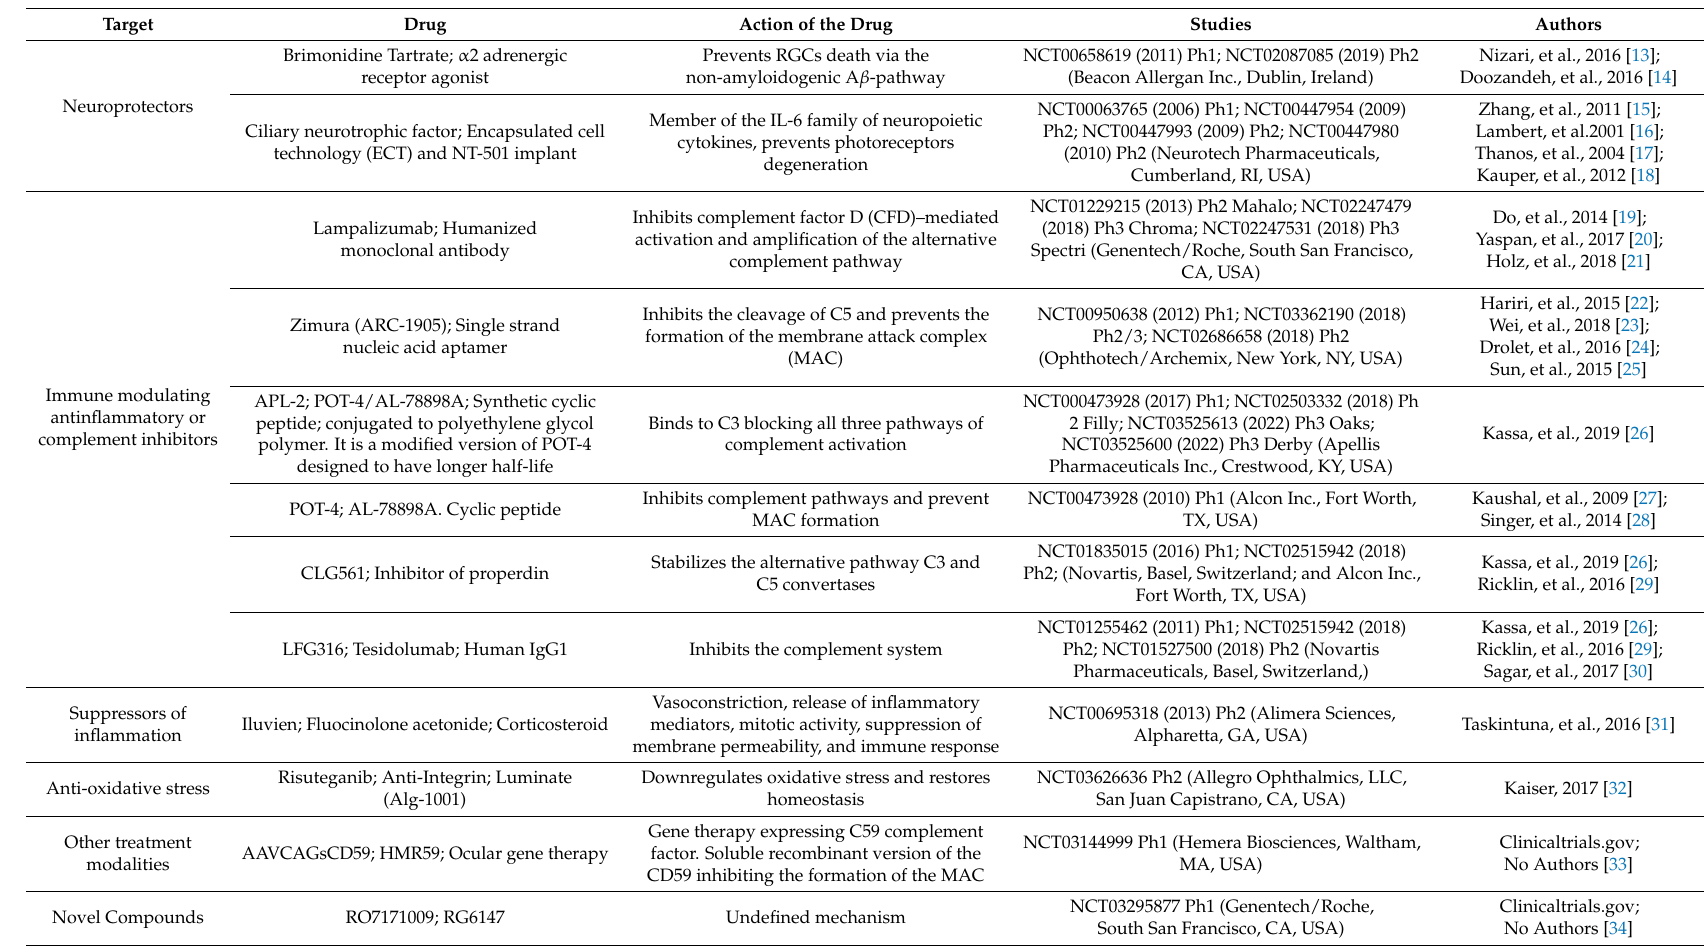
Table 1. Summary of the clinical trials for the intravitreal injections (IVIs) of geographic atrophy